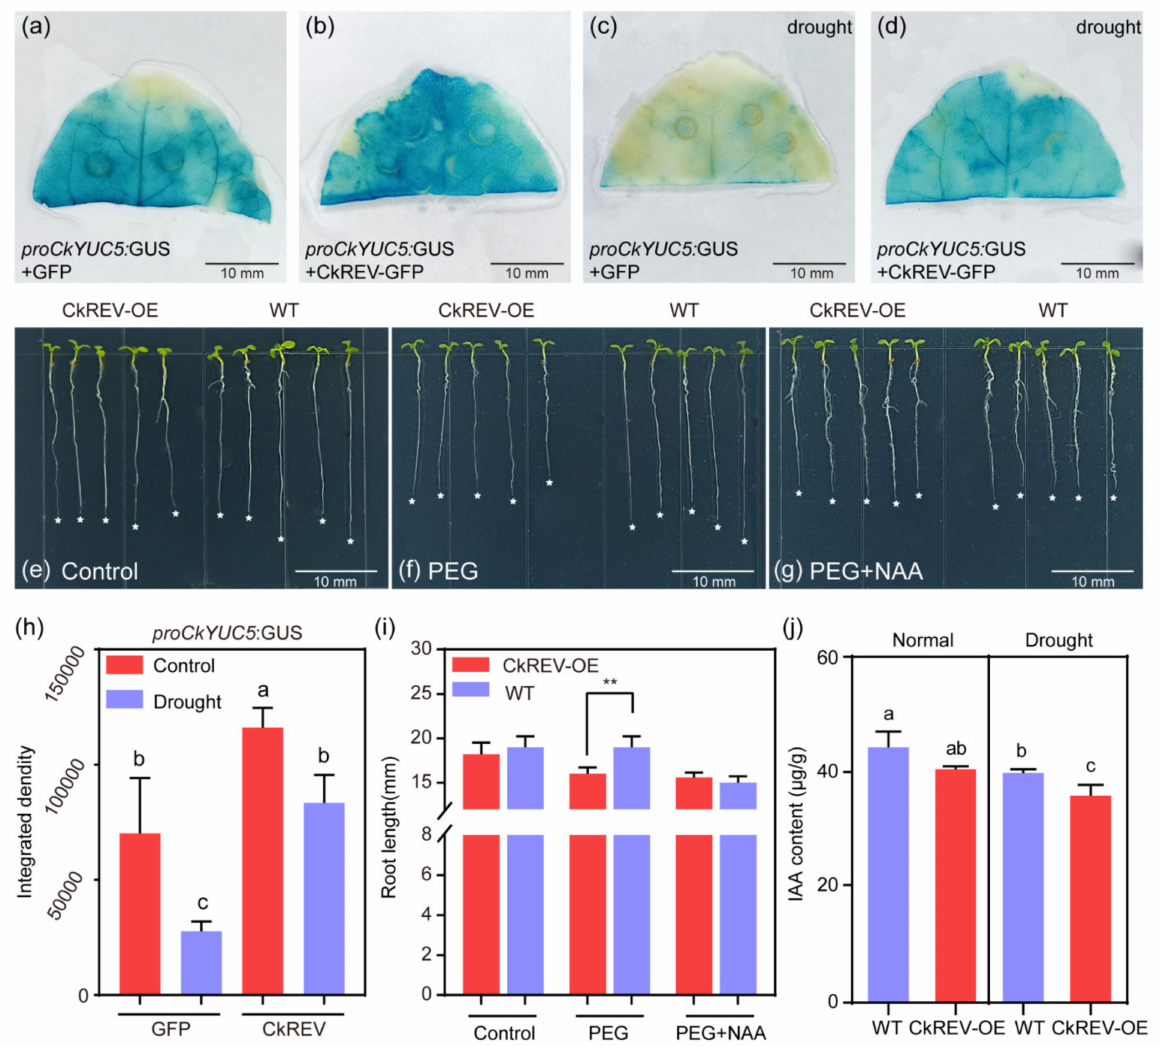
Figure 5. CkREV bidirectionally regulates the expression of CkYUC5 and inhibits the A. thaliana root length under drought stress. ( a – d ) Observe the expression changes of CkYUC5 under different treatment conditions through tobacco leaves cultured for 28 days (n = 3 biologically independent samples); ( a ) Localization of CkYUC5 in the tip of tobacco leaf under normal culture conditions; ( b ) Localization of CkYUC5 in the tip of tobacco leaf after CkREV overexpression; ( c ) Localization of CkYUC5 in the tip of tobacco leaf after PEG treatment; ( d ) Localization of CkYUC5 in the tip of tobacco leaf after overexpression of CkREV treated with PEG; ( e – g ) Four days after germination on 1/2MS plates, the phenotype of root length change of A. thaliana CkREV –OE strain and wild type under normal culture conditions, PEG treatment and PEG treatment with NAA added for 3 days (n = 5 biologically independent samples); ( h ) GUS staining statistics of A. thaliana CkREV –OE strain and wild type under different treatments; ( i ) Root length statistics of A. thaliana CkREV –OE strain and wild type under different treatments; ( j ) IAA content determination. Scale bars in ( a – g ), 10 mm. ( i ) Data are shown as the mean ± SD of five independent experiments; Student’s t –test is employed to measure statistical significance between two samples with a confidence level of 0.95 (**, p < 0.01). ( h , j ) Data are shown as the mean ± SD of three independent experiments. One–way ANOVA was performed for the statistical analysis, where different letters represent significant differences ( p <